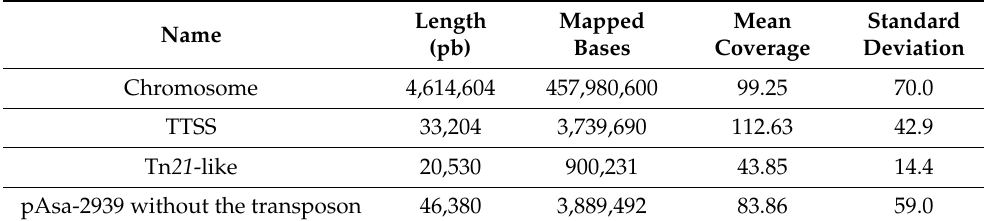
Table 3. Read coverage in the raw sequencing of SHY15-2939.